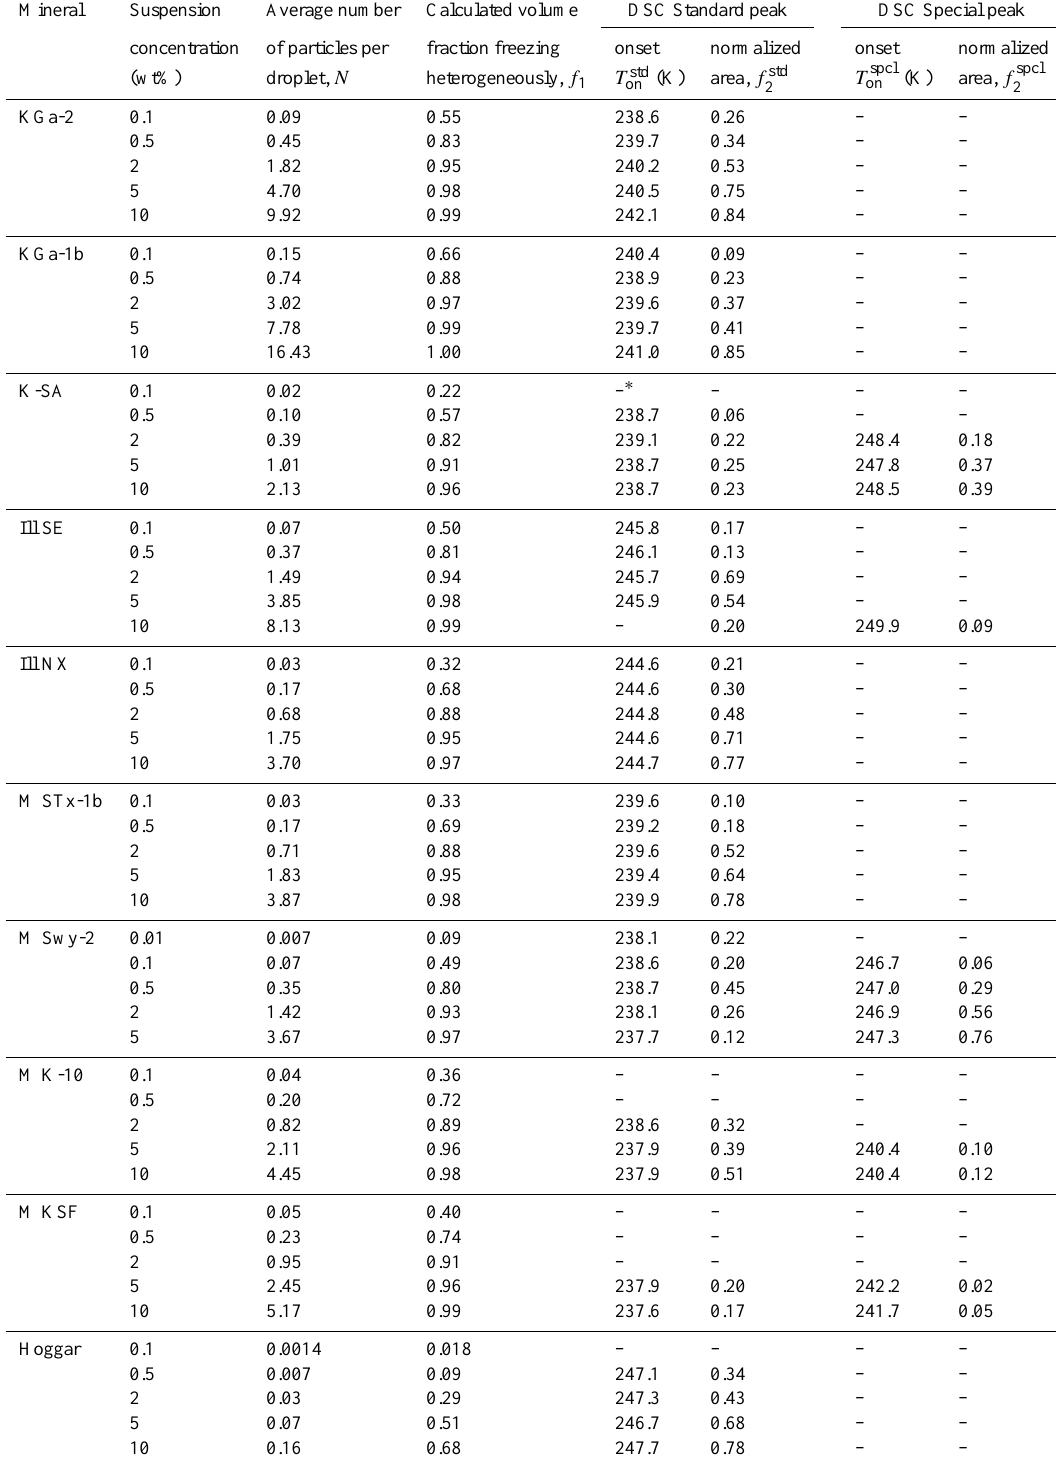
Table 3. Percentage of activated droplets depending on the mass concentration of the clay in suspension for all the minerals studied in this